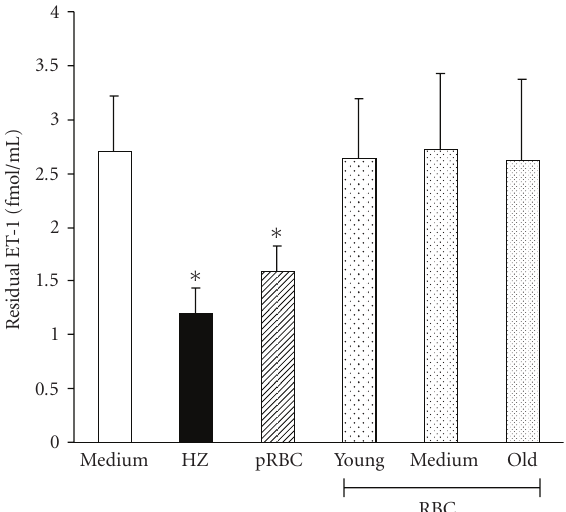
Figure 4: Fractions isolated by density gradient from the parasite culture have di ff erent ability to remove ET-1. Parasite culture (D10 strain) where density separated by Percoll/sorbitol gradient. Each fraction was incubated with synthetic ET-1 (2.5fmol/mL) for 24 hours and, at end of the incubation, ET-1 was determined by ELISA. Recovery of ET-1 incubated in: medium (empty bar); RBC separated by di ff erent density and age (subdivided in young, medium and old) (dotted bars); pRBC at the trophozoite stage (4– 8% parasitemia) (striped bar); fraction containing HZ (black bar). Results represent the mean ± SD from three di ff erent experiments. P = . 007 HZ versus control; P = . 038 pRBC versus